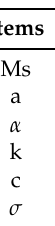
Table 2. Main parameters of the JA anisotropic hysteretic